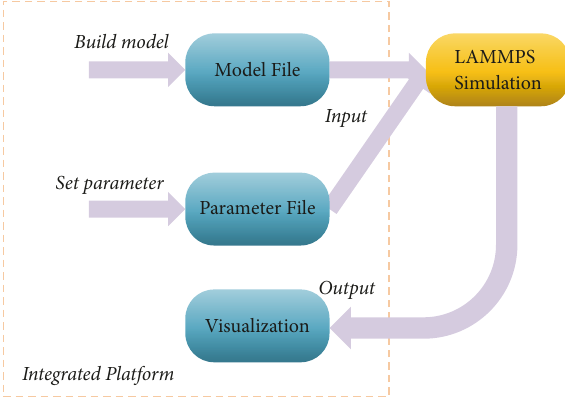
Figure 15: Pipeline for integrated